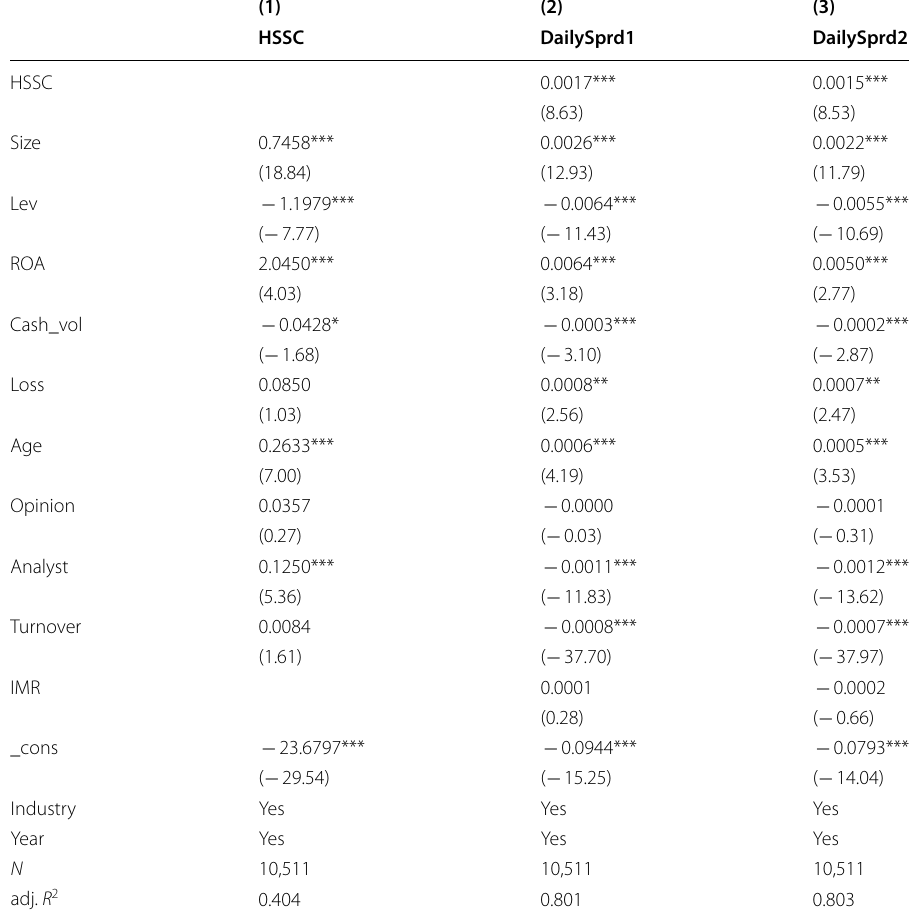
Table 8 Robustness checks: Heckman two-step